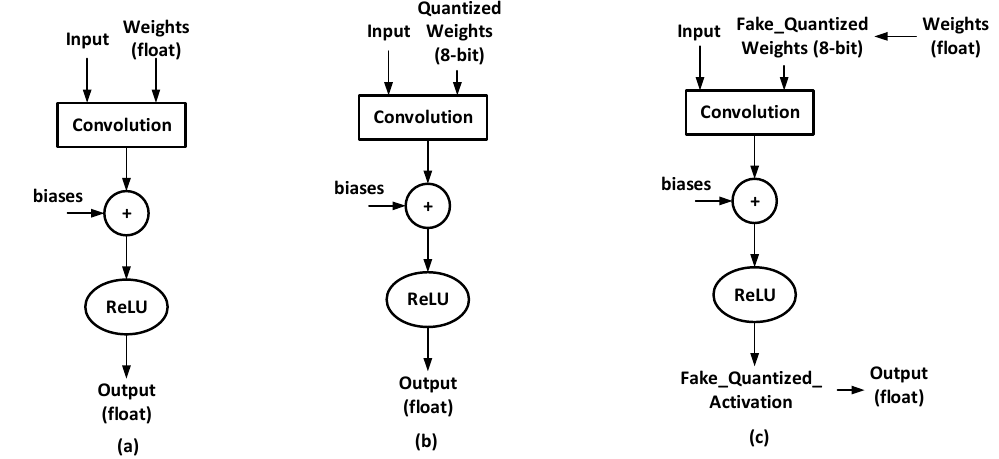
Figure 1. ( a ) Convolution without quantization, ( b ) convolution with post-training weight quantization, and ( c ) convolution with quantization-aware weight training.